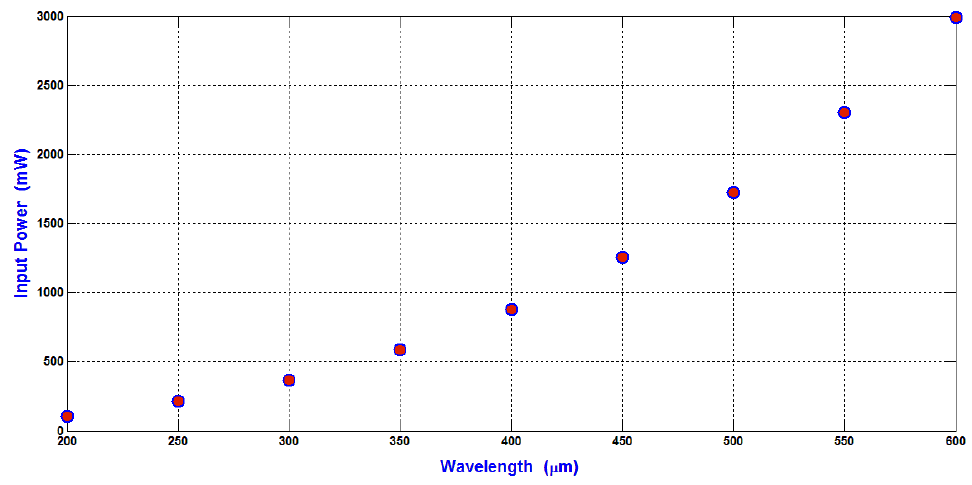
Figure 7. The relation between the minimum input power required to shift the WBCs to the side wall of the main SSAW microchannel at the end of the working time of SAW and the wavelength.